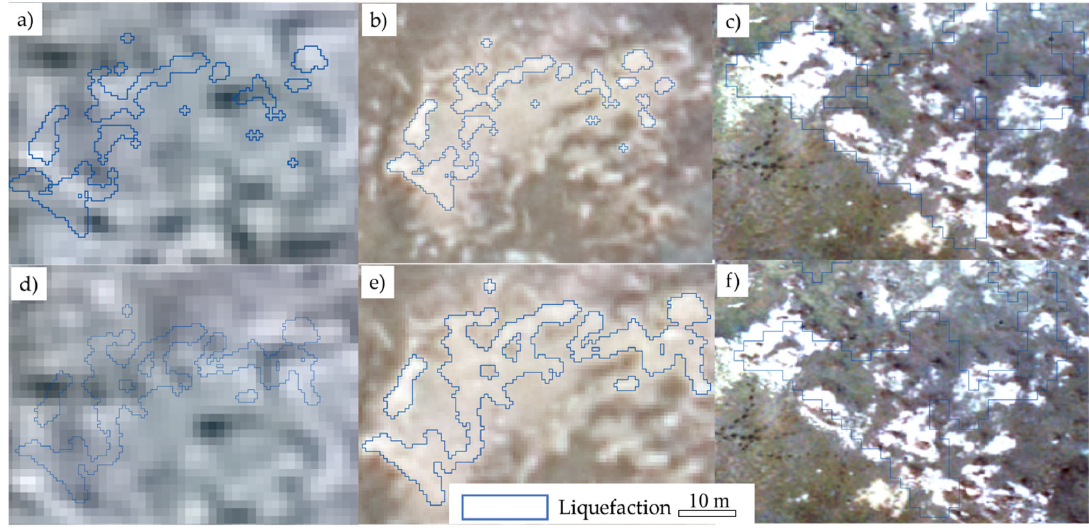
Figure 7. The extracted liquefaction (region Ⅰ ) by the two proposed methods. ( a ) GF-1D image pre-earthquake with liquefaction extracted by RF. ( b ) GF-7 image post-earthquake with the liquefaction predicted by RF. ( c ) UAV image post-earthquake with liquefaction predicted by RF. ( d ) GF-1D image pre-earthquake with liquefaction predicted by GBDT. ( e ) GF-7 image post-earthquake with liquefaction predicted by GBDT. ( f ) UAV image post-earthquake with liquefaction predicted by GBDT.